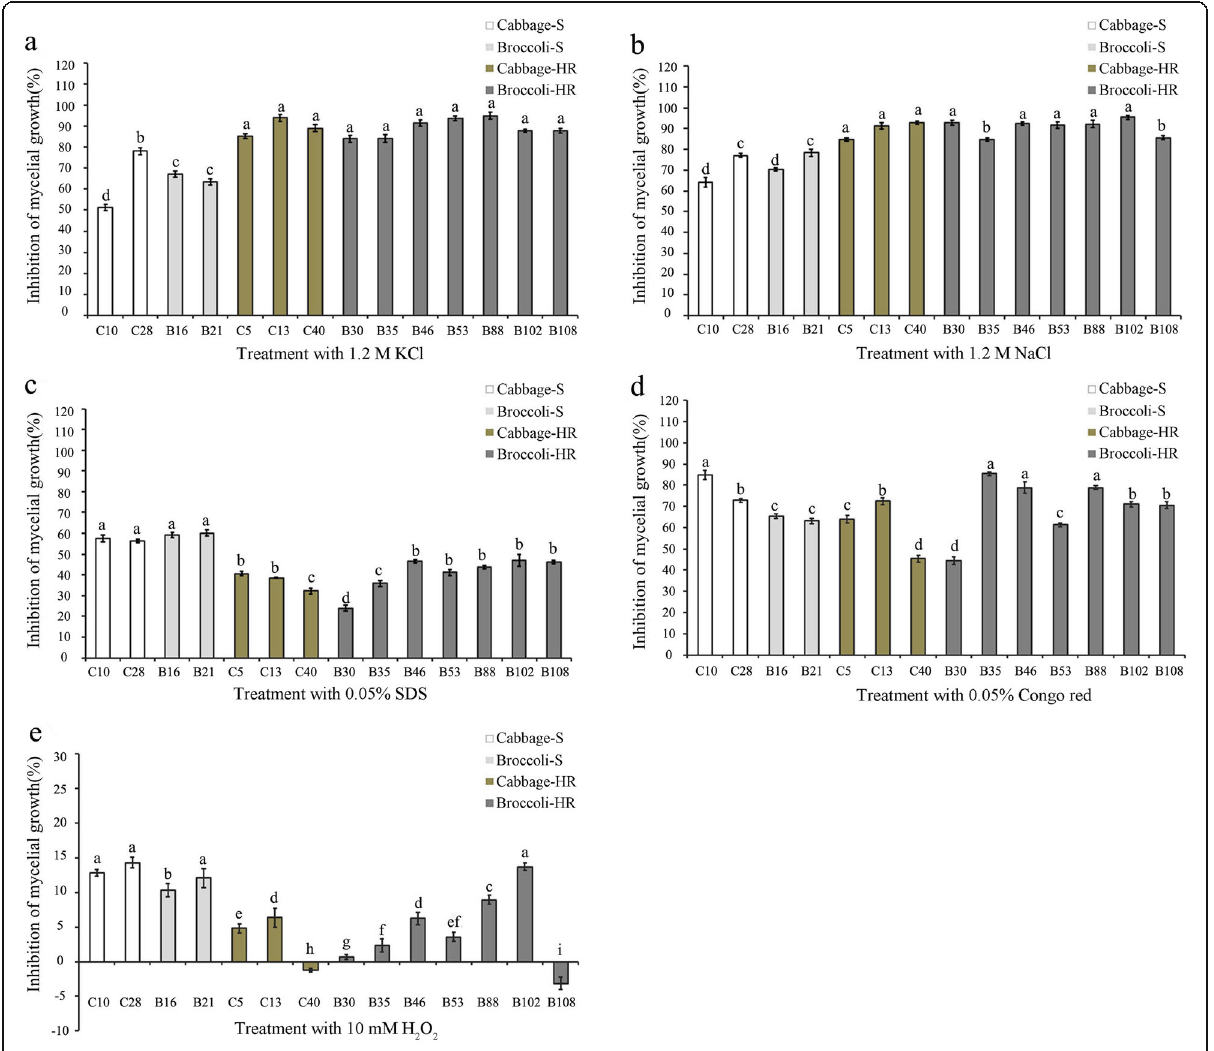
Fig. 3 Sensitivity comparison among A. alternata Pro S and Pro HR isolates to osmotic stress agents generated by 1.2 M KCl ( a ); 1.2 M NaCl ( b ); 0.05% SDS ( c ); 0.05% Congo red ( d ) and 10 mM hydrogen peroxide (H 2 O 2 ) ( e ). Bars denote the standard errors of three repeated experiments. Values on bars followed by the same letter are not significantly different from each other at P = 0.05. The Pro S isolates include C10, C28, B16 and B21. The Pro HR isolates include C5, C13, C40, B30, B35, B46, B53, B88, B102 and